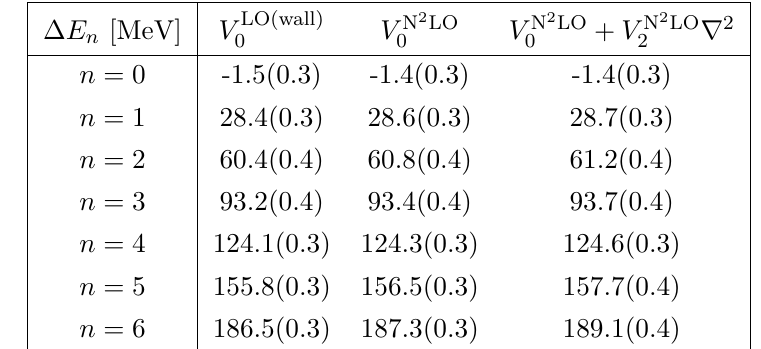
Table 3 . The (cid:12)nite volume spectra using V LO(wall) evaluated at t=a = 13.